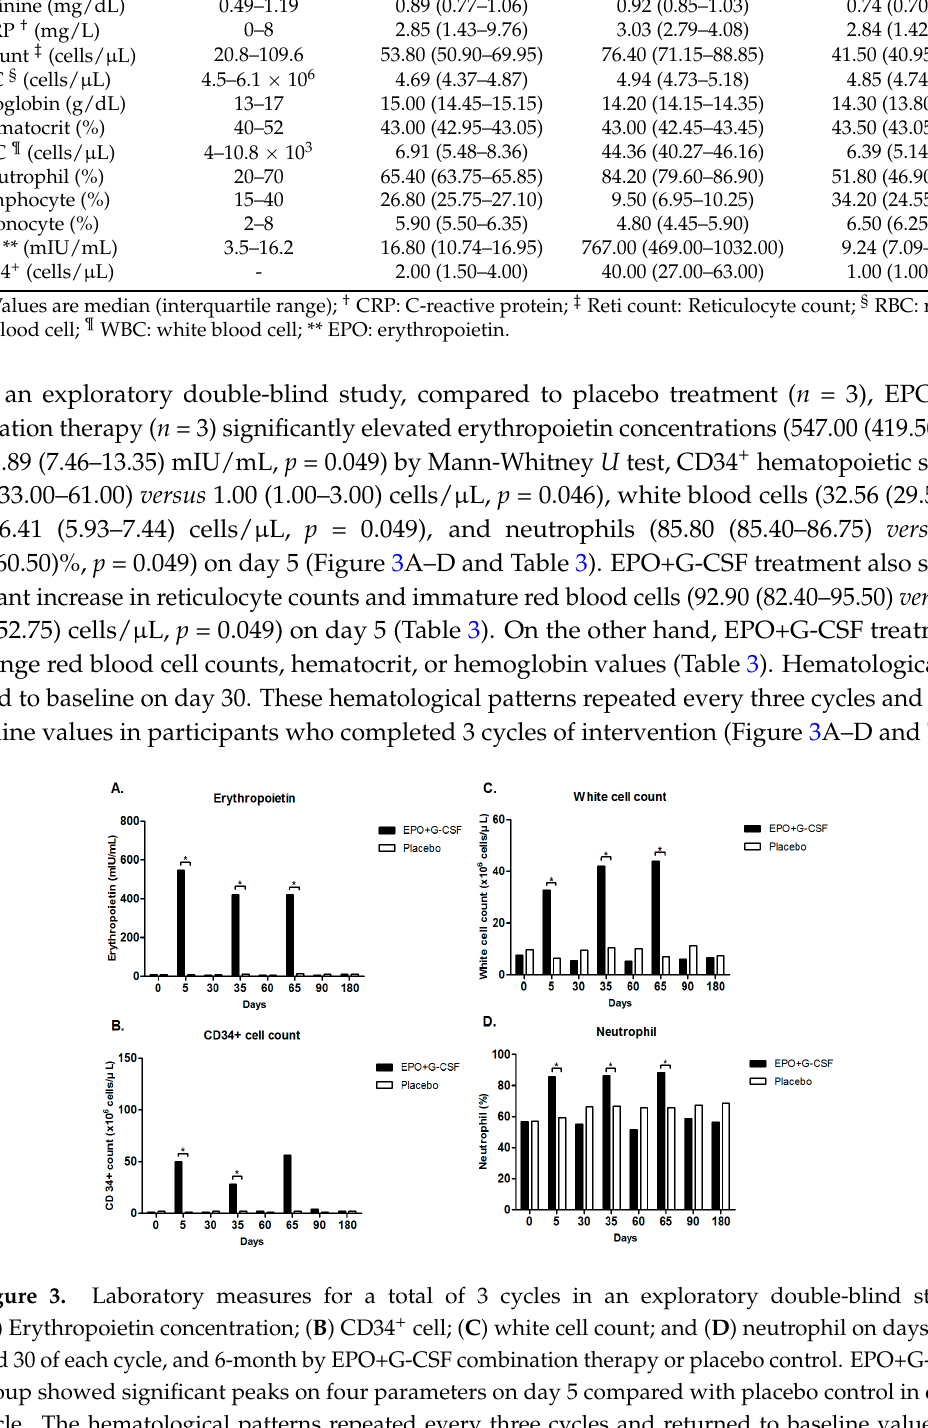
Table 2. Hematological parameters of the EPO and G-CSF combination therapy in stroke patients in a pilot study.